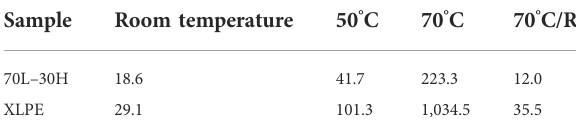
TABLE 1 Average electrical treeing growth rate of XLPE and 70L – 30H blends at various temperatures ( μ m min − 1 ).